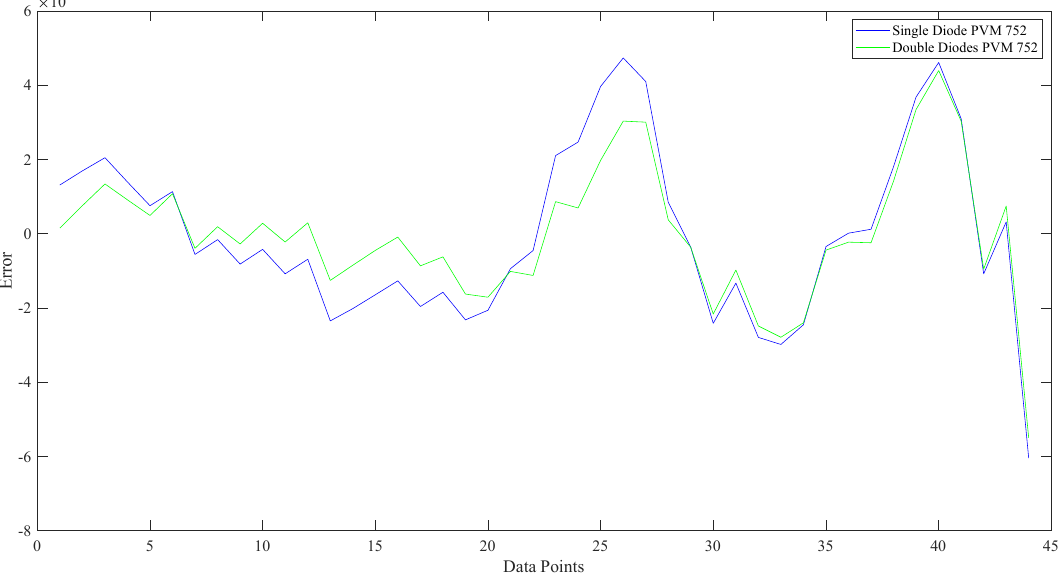
Figure 14. Error vs. data points for single diode and double diodes—PVM 752 GaAs photovoltaic panel.